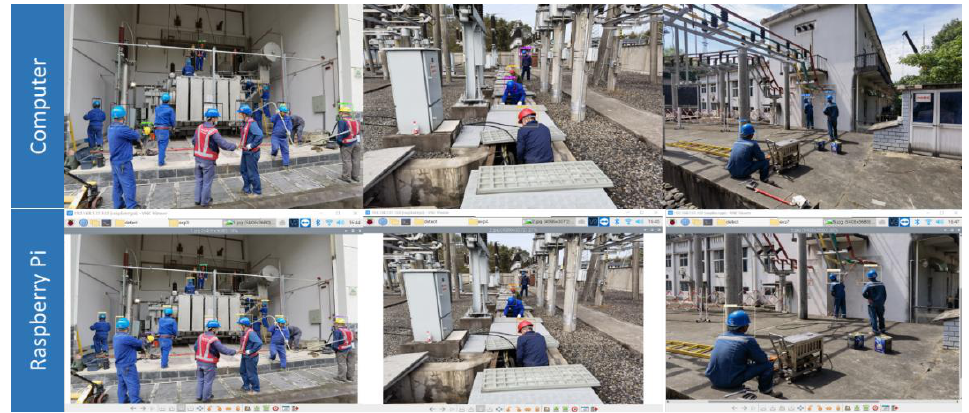
Figure 8. Examples of test results on images.